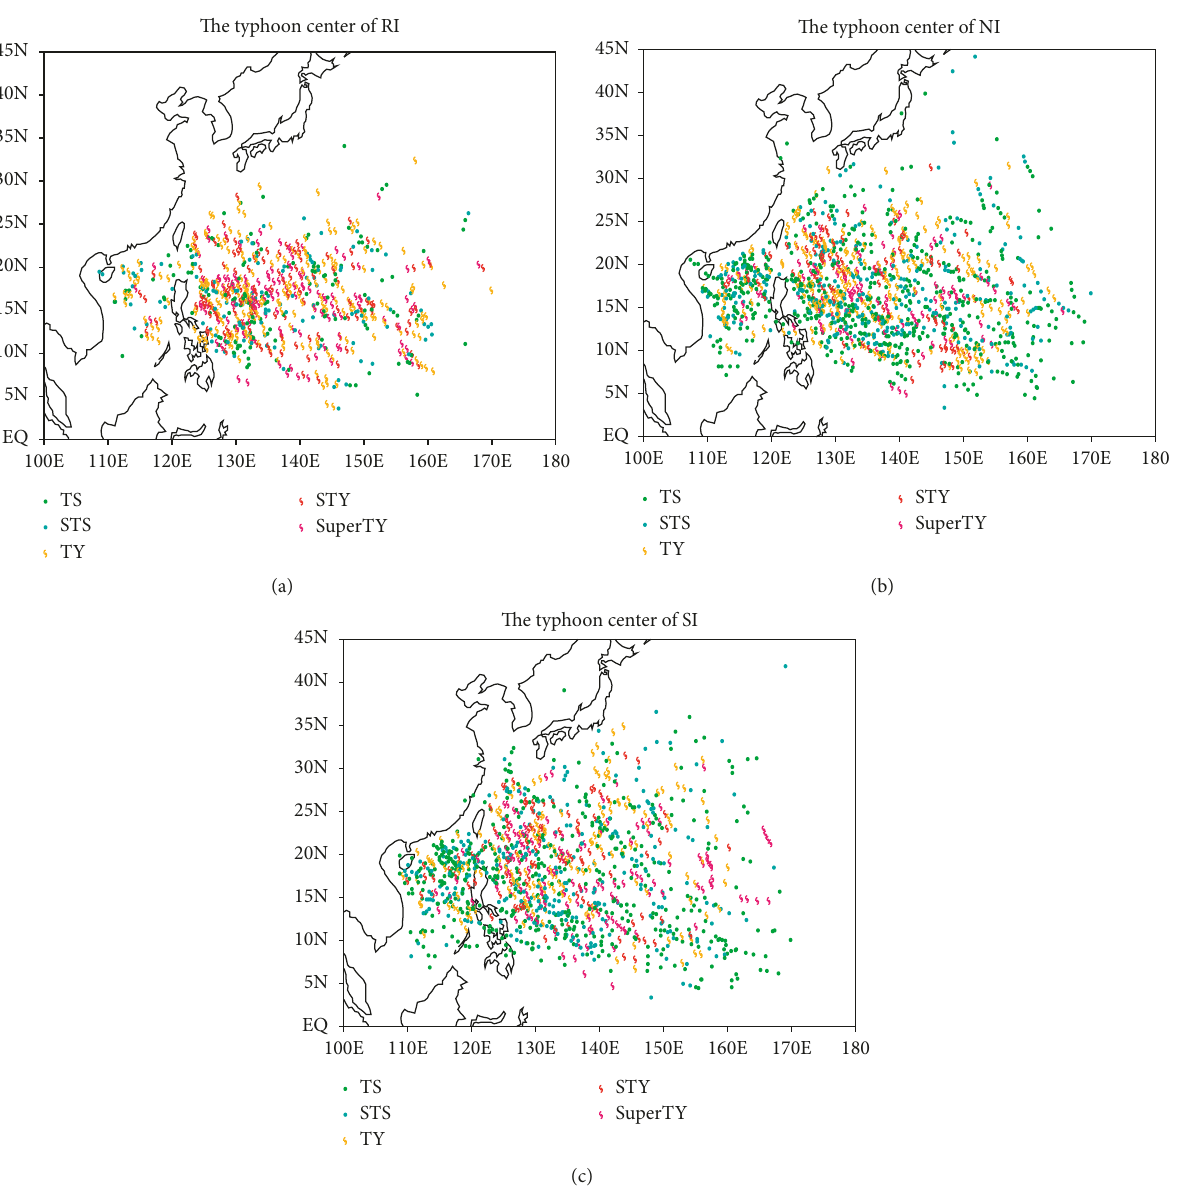
Figure 2: The location distribution of (a) RI cases, (b) NI cases, and (c) SI cases. TC intensities over the Northwest Pacific basin are divided into five categories: tropical storm (TS, 17.2m s − 1 ≤ V max ≤ 24.4m s − 1 ), severe tropical storm (STS, 24.5m s − 1 s ≤ V max ≤ 32.6m s − 1 ), typhoon (TY, 32.7m s − 1 ≤ V max ≤ 41.4m s − 1 ), strong typhoon (STY, 41.5 m s − 1 ≤ V max ≤ 50.9 m s − 1 ), and super typhoon (SuperTY, V max ≥ 51.0m s − 1